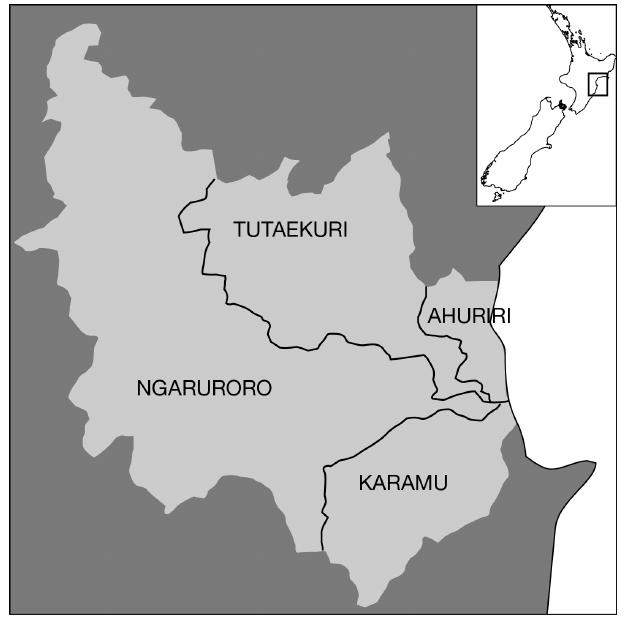
Fig. 1 . Map showing location of T ū taekur ī , Ahuriri, Ngaruroro, and Karam ū (TANK) catchments, Hawke’s Bay, New Zealand.